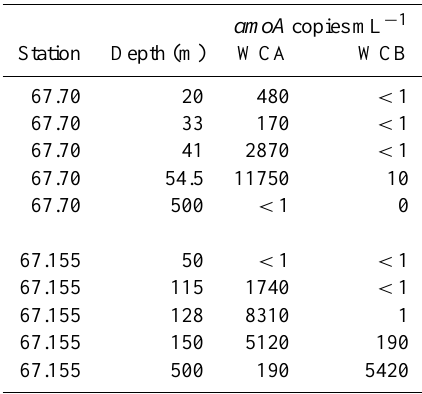
Table 2. Abundance of two ecotypes of ammonia-oxidizing ar- chaea: water column A (WCA) and water column B (WCB) based on the abundance of archaeal amoA genes determined by quanti- tative PCR using ecotype-specific primers and probes (Mosier and Francis,